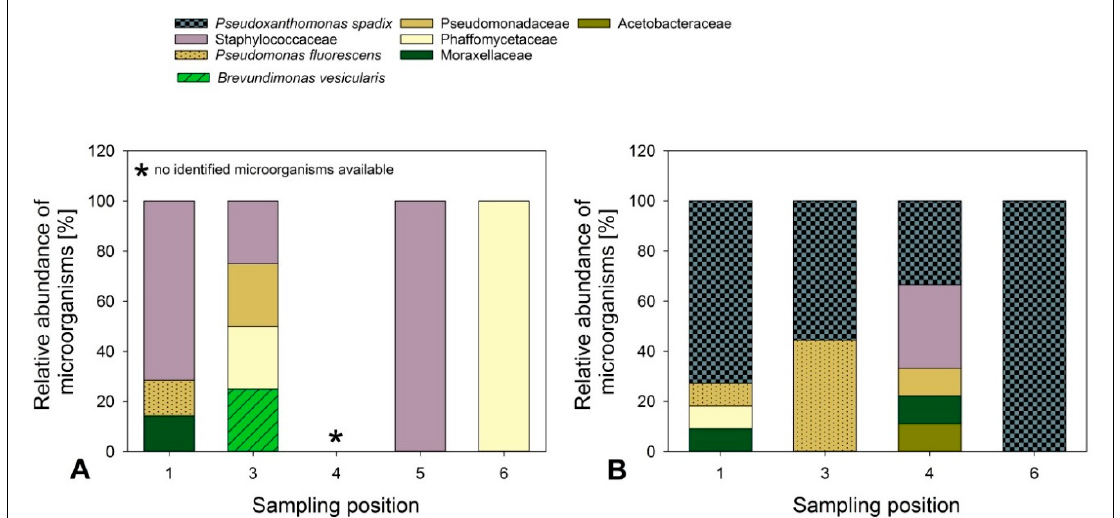
Figure 5. Culturable microbial community structure of endive lettuce (identified colonies only) along the washing process chain. The washing was conducted with the addition of PTW in the second wash (180 s) (trial E) and the samples were analyzed after washing ( A ) and after storage for seven days at 2 ◦ C ( B ). Sampling positions: (1) endive raw material; (3) endive after pre-rinsing; (4) endive after first wash; (5) endive after second wash; (6) endive after final rinsing.